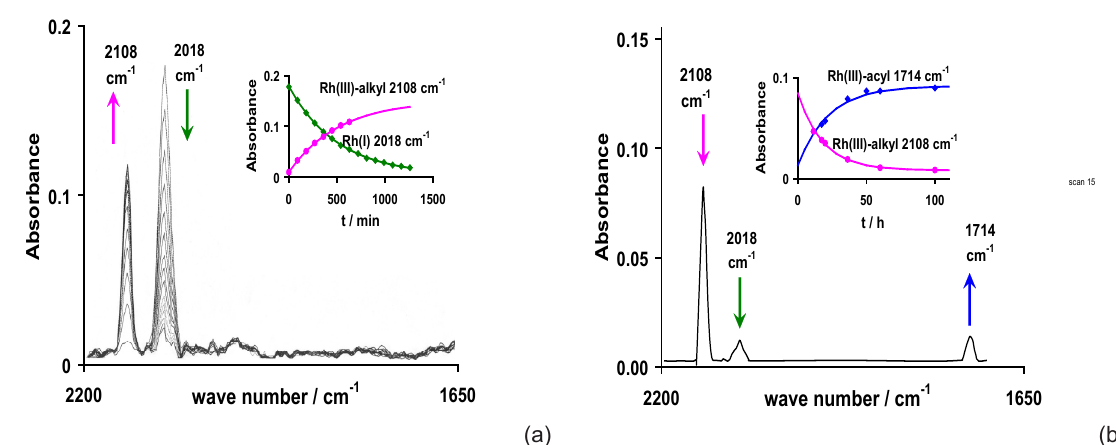
I and [Rh(PhCOCHCOPh)(CO)(P(OCH ) CCH )] as monitored 3 2 3 3